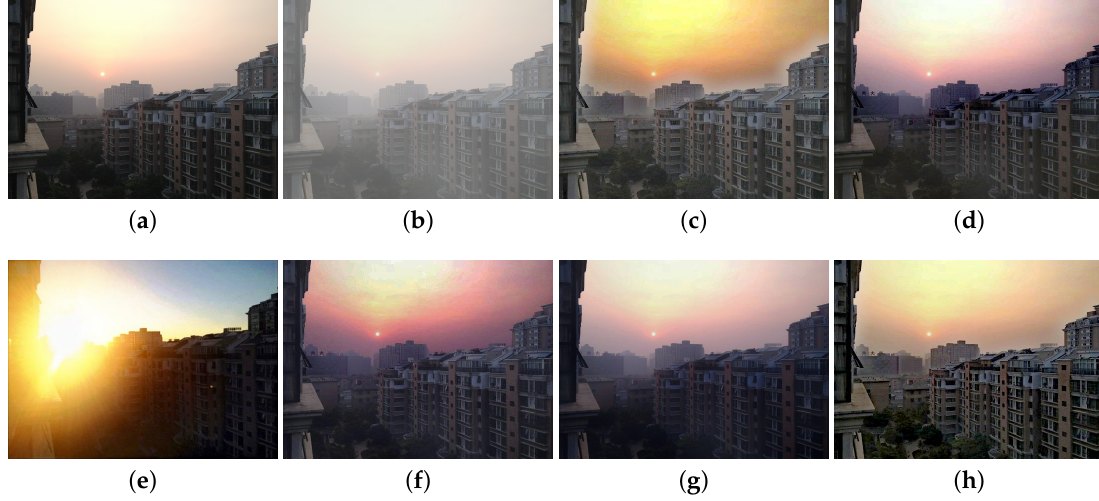
Figure 10. Buildings of the SOTS-outdoor dataset. ( a ) Buildings. ( b ) input blur image. ( c ) DCP; ( d ) Berman; ( e ) DCPDN; ( f ) Zhu; ( g ) Golts; ( h )